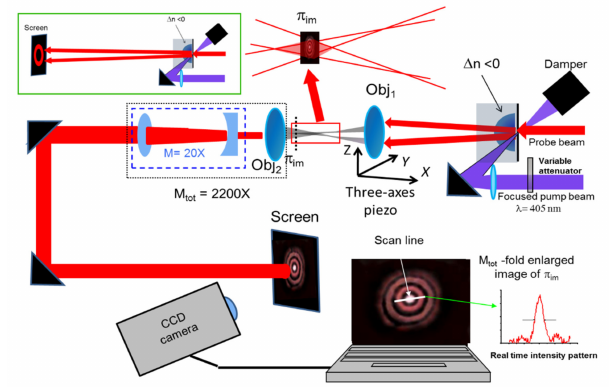
Figure 8. Experimental apparatus. The input probe beam travels through the heated PDMS, which modifies and transmits it to the focusing objective Obj 1 (focal length 2.6 mm), mounted on a three-axis piezo. The focusing action determines the formation of a superposition volume (evidenced in the red box and exploded in the upper part) where the long focus develops. The section of the focus located on the plane π im is conjugated onto the observation screen by a 2-stage optical magnifier, composed of an objective Obj 2 (focal length 2.6 mm, measured magnification 110x, and a 20x Galilean telescope. The focus image, magnified 2200 times, is then projected onto the screen and imaged by a CCD camera. An image processing software permits checking the image intensity on a given line in real time, allowing the monitoring of the change in the spot dimensions in response to changes in P h , obtained with a variable attenuator. The measure of the far field annular distributions is performed without Obj 1 and the 2200x magnification system (green frame in the upper left